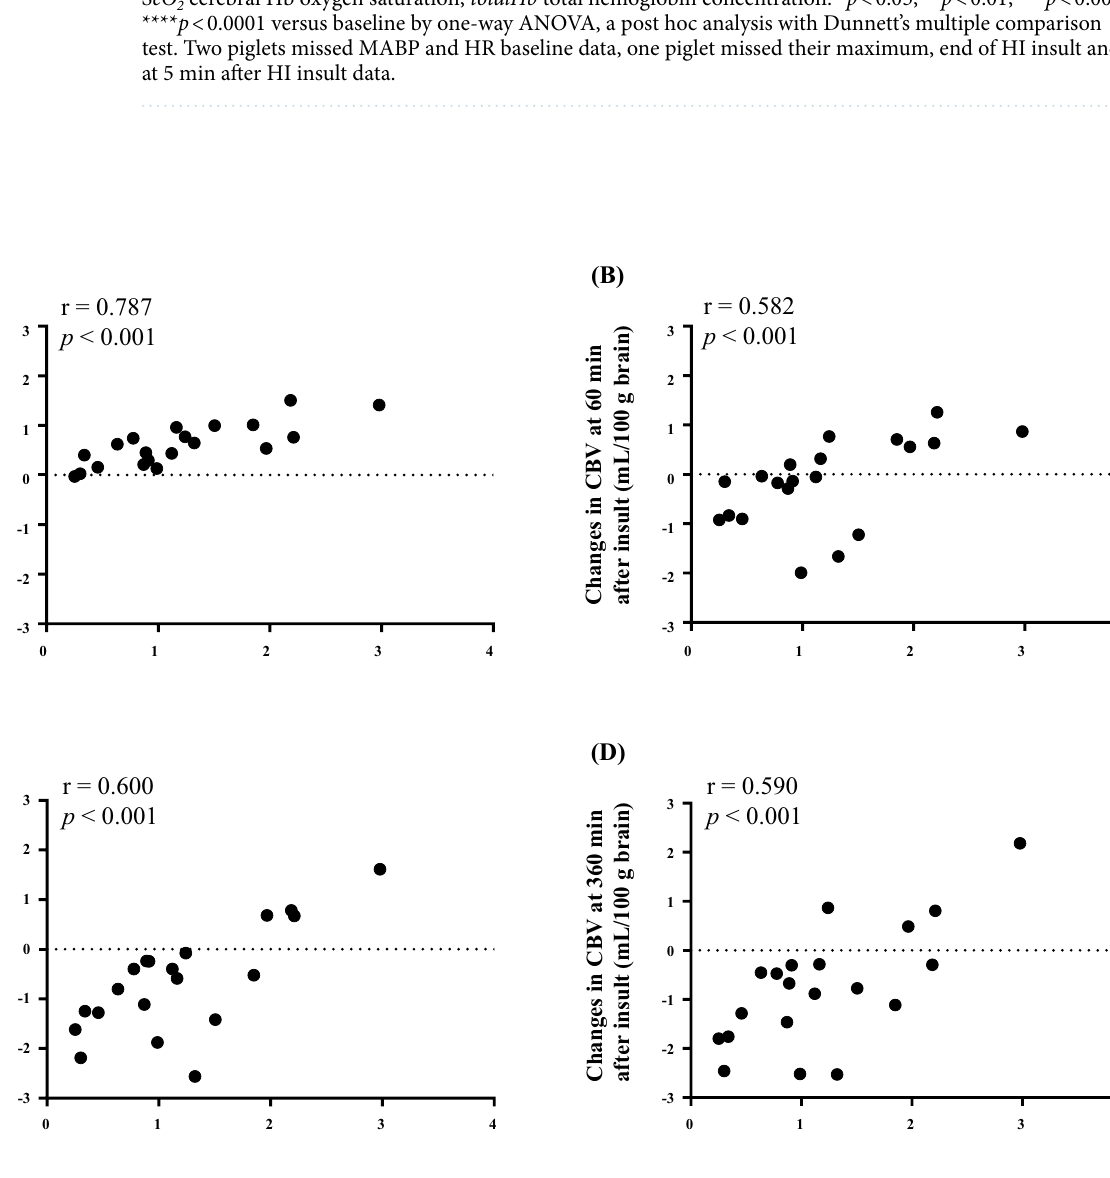
Figure 1. Correlation between changes in CBV during insult and changes in CBV at ( A ) 5 min, ( B ) 60 min, ( C ) 180 min, and ( D ) 360 min after insult. CBV changes were defined as the differences between the maximum CBV value during insult and the CBV values 5, 60, 180, and 360 min after